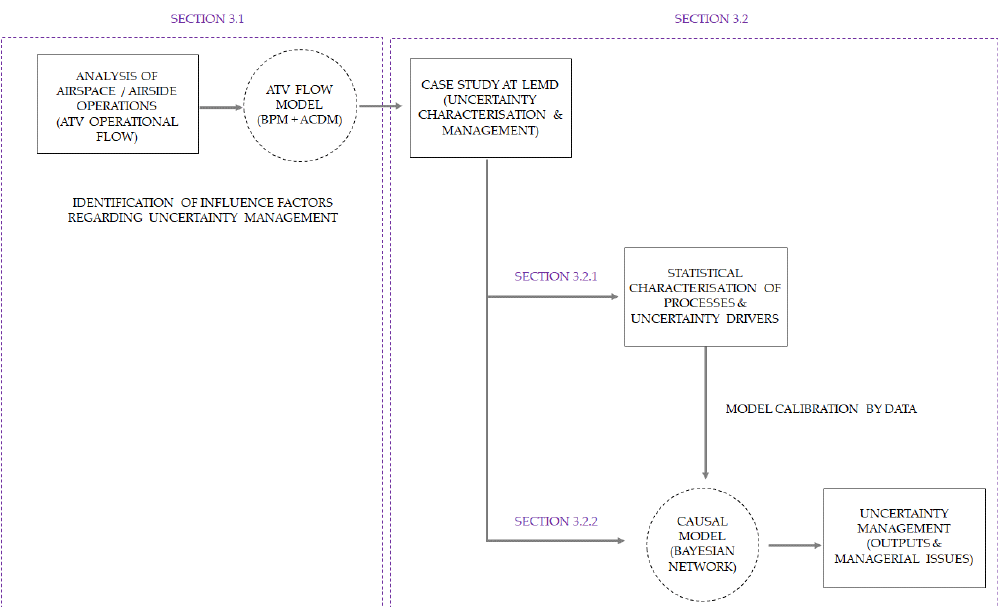
Figure 1. Methodological approach for uncertainty management at the Airport Transit View (ATV).